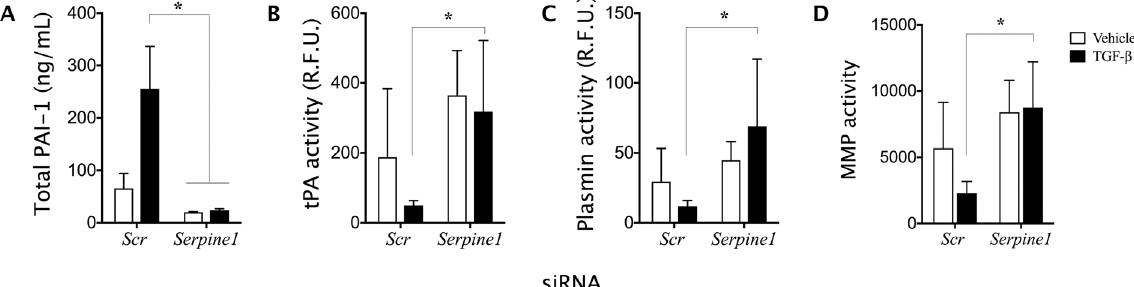
Figure 6. siRNA knockdown of Serpine1 abrogates TGF- β 1 suppression of tPA, plasmin and MMP activity in primary WT tendon cultures. Primary flexor tendon cells from WT mice transfected with scrambled non- targeting siRNA (siRNA Scr ) or siRNA targeting Serpine1 (siRNA Serpine1 ) were treated with TGF- β 1, tPA and plasminogen for 48 hours. The culture media was then collected and assessed for ( A ) total secreted PAI-1 protein levels and the proteolytic activity of ( B ) tissue plasminogen activator (tPA), ( C ) plasmin, and ( D ) MMPs using fluorescent substrate (FRET) assays. Data are presented as mean ± standard deviation. Asterisks indicate significant differences between siRNA Scr and siRNA Serpine1 (p < 0.05).